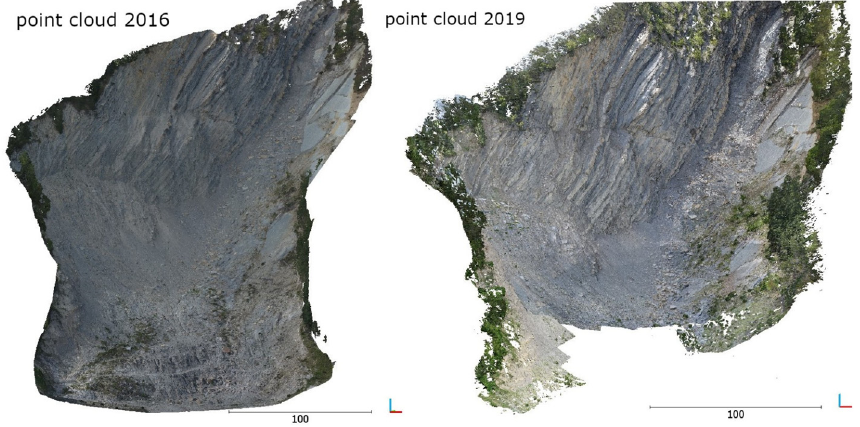
Figure 3. SfM-based point clouds derived from the drone photogrammetric surveys. Campaigns were carried out in April 2016 ( left ) and May 2019 ( right ).